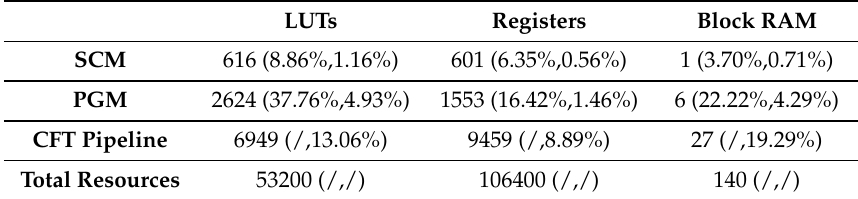
Table 3. Resource Usage on Xilinx Zynq 7000 SoC